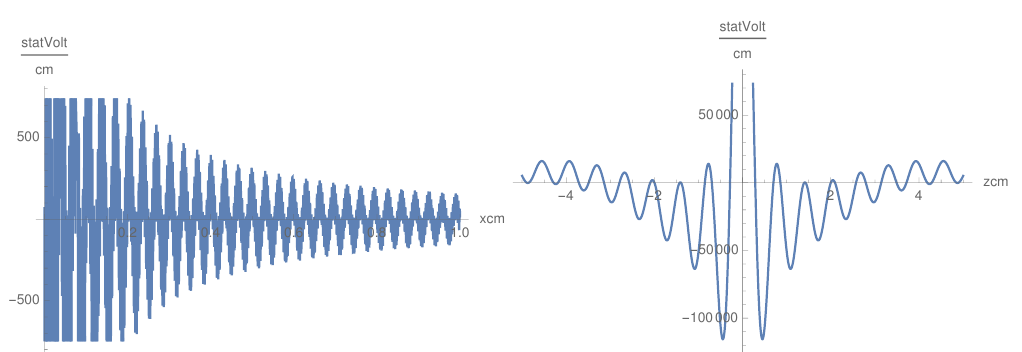
Figure 11. E z as a function of x for z = − 2 cm and ω = 10 9 Hz ( left ), and E z as a function of z , ω = 1 × 10 9 Hz and x = 0.004 cm ( right